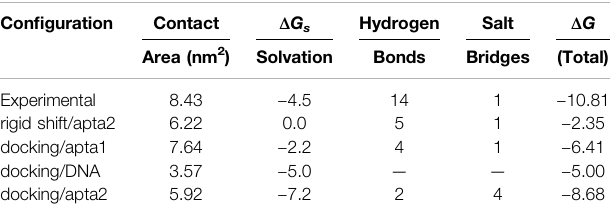
TABLE2| SummaryoffreeenergycalculationswiththePDBePISAutility(Krissinel and Henrick, 2007). Δ G s , Δ G values in